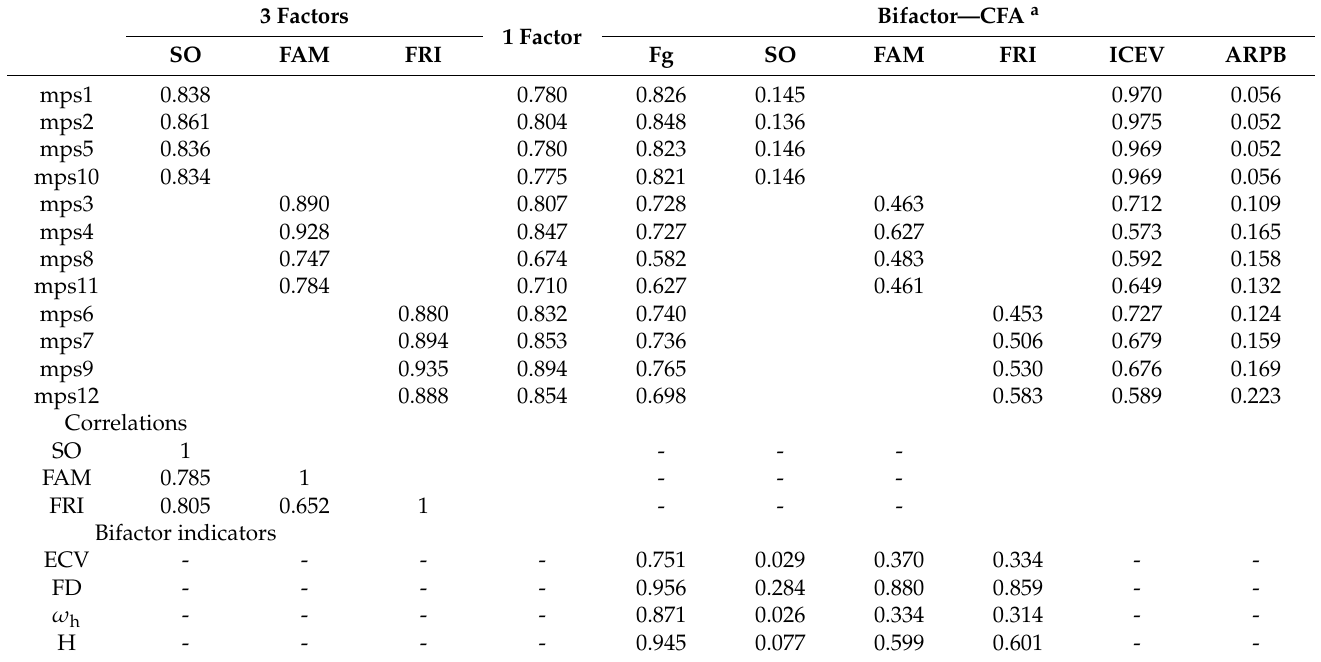
Table 4. Measurement models evaluated in the MSPSS using CFA ( n =